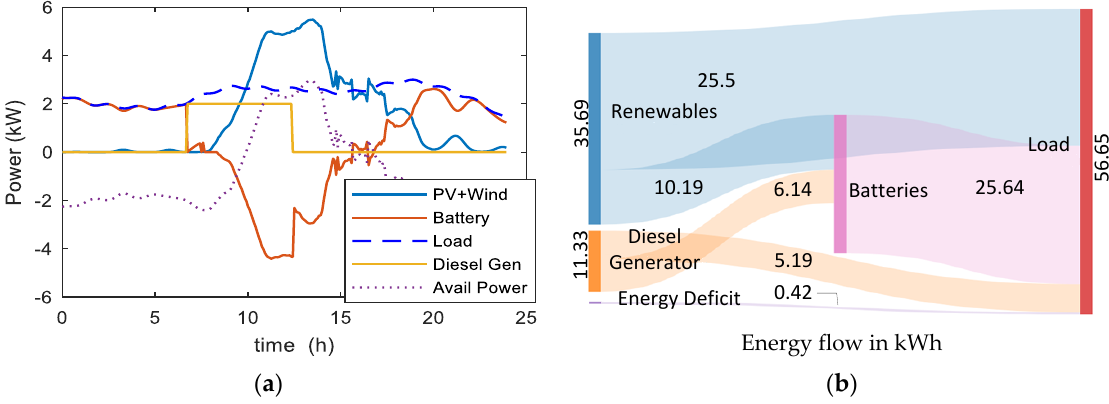
Figure 6. Node 2 at isolated daily operation (NMPC off): ( a ) Systems operation; ( b ) Energy flow (kWh).